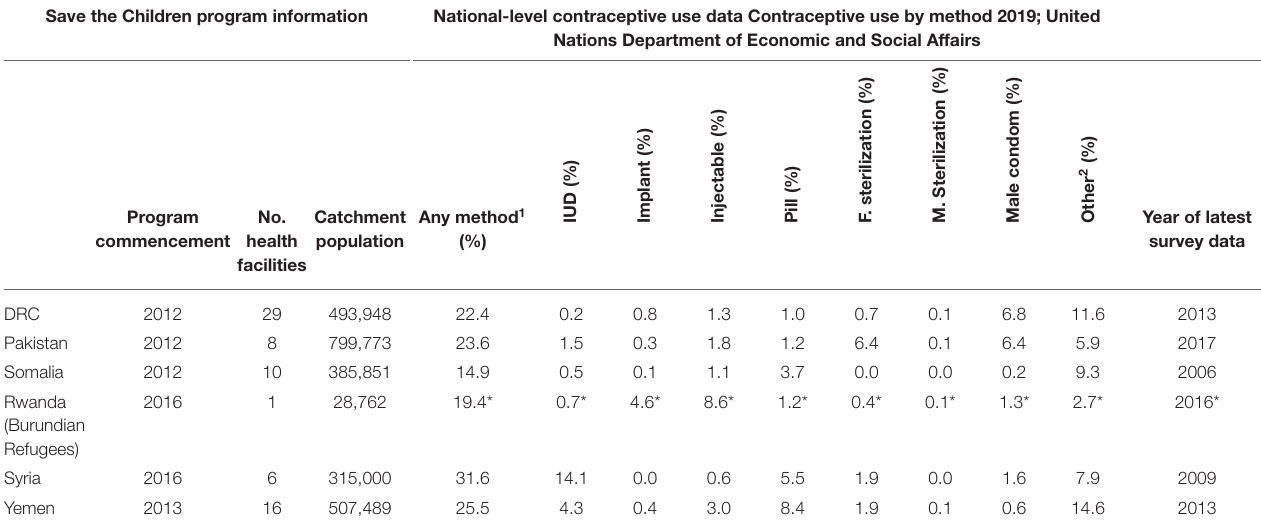
TABLE 1 | Overview of family planning programs in six countries. Save the Children program